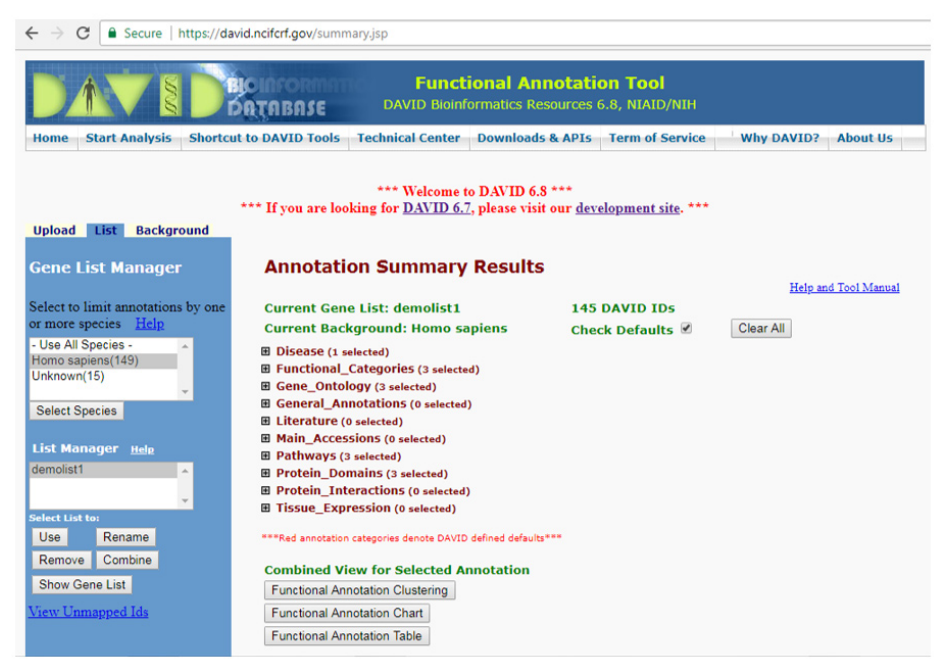
Figure 5. Obtaining the results. Screenshot of the different types of analysis options provided by DAVID for a given geneset. For the purpose of this tutorial, the relevant output is the “Functional Annotation Table” located at the bottom of the page.